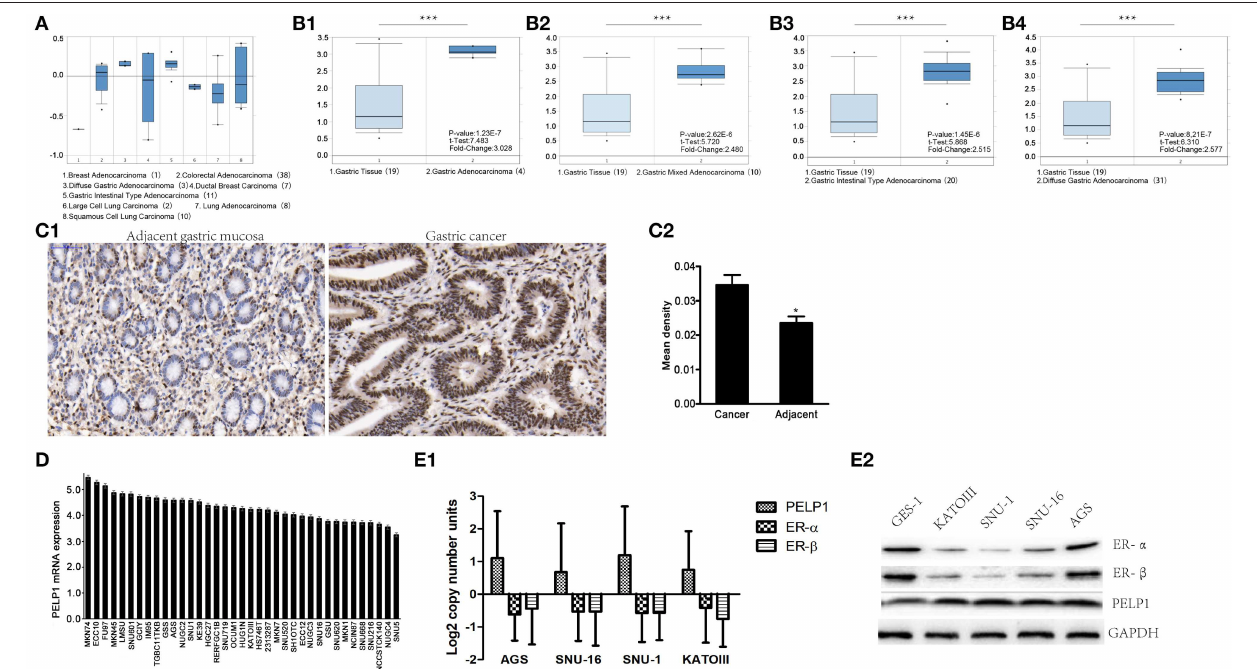
FIGURE 1 | PELP1 expression was elevated in gastric cancer tissues and cells comparing with corresponding counterparts. (A) Box plots derived from gene expression data in ONCOMINE comparing expression of a specific PELP1 in different cancer tissues. (B1–B4) Oncomine data showed that PELP1 expression was elevated in GC tissues as compared with gastric normal tissues. (C1) Representative images of PELP1 level in normal gastric mucosa and GC specimens by immunohistochemistry. The positive rate of PELP1 in gastric cancer specimens was higher than in normal gastric mucosa. (C2) , PELP1 expression in normal gastric and GC tissues. The mean density of cancerous and adjacent gastric tissues from all 36 cases is illustrated at top graph. Difference was detected between the mean density of cancerous tissues (0.0346 ± 0.0172) and that of adjacent tissue (0.0235 ± 0.0115) using paired students’ test, p < 0.05. (D) PELP1 was expressed in different stomach cell lines from CCLE. (E1,E2) The level of PELP1, ER α and ER β was induced from Oncomine data base and validated by western bot in four GC cell lines and nomal gastric epithelium cell line GES-1. Mean ± SEM was applied for analysis (* p < 0.05, *** p < 0.001).